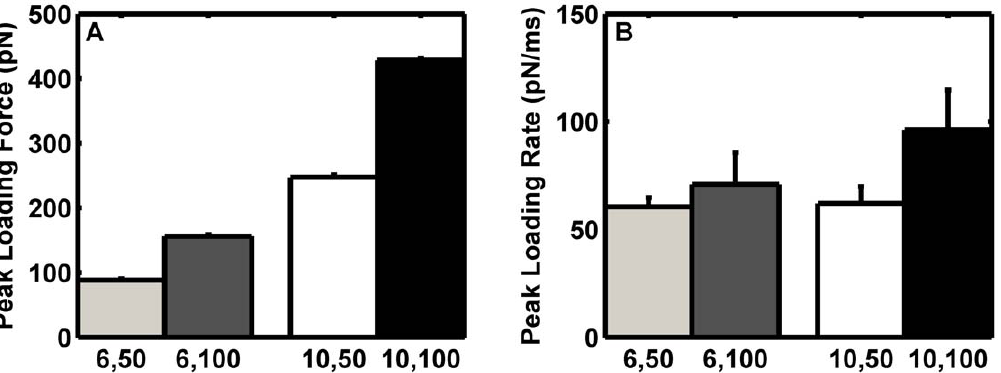
Figure 6. Peak loading characteristics for single bonds. Simulation results for 6 m m-diameter spheres with a 50 s 2 1 (grey) and 100 s 2 1 (dark grey) wall shear rate and for 10 m m-diameter spheres with a 50 s 2 1 (white) and 100 s 2 1 (black) wall shear rate were screened for single bond loading events. (A) Statistical compilation of mean peak single bond loading forces. The error bar depicts the standard deviation. (B) Statistical compilation of peak loading rates. The error bar depicts the standard